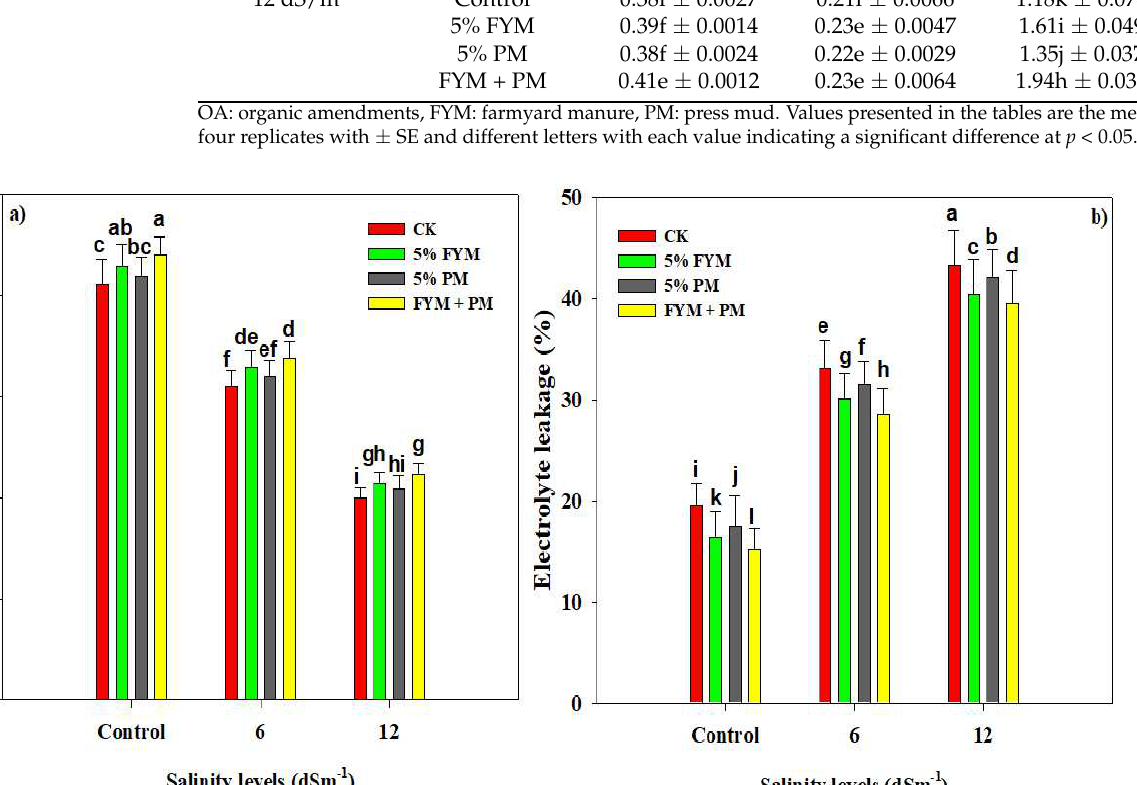
difference at p < 0.05.